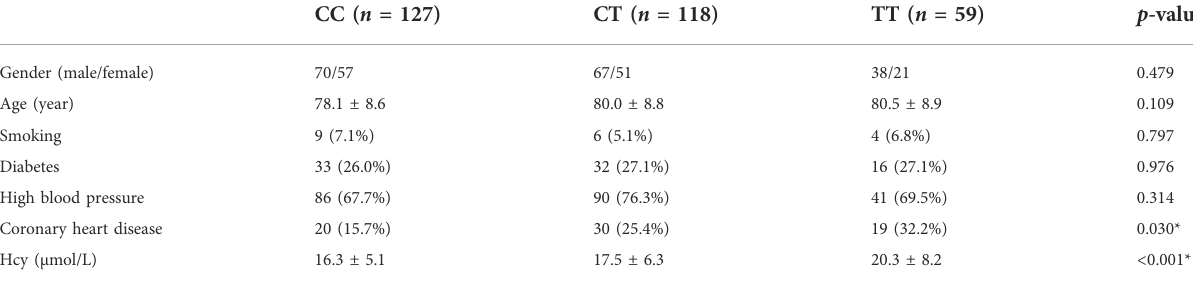
TABLE 1 Clinical characteristics of patients in three groups of MTHFR